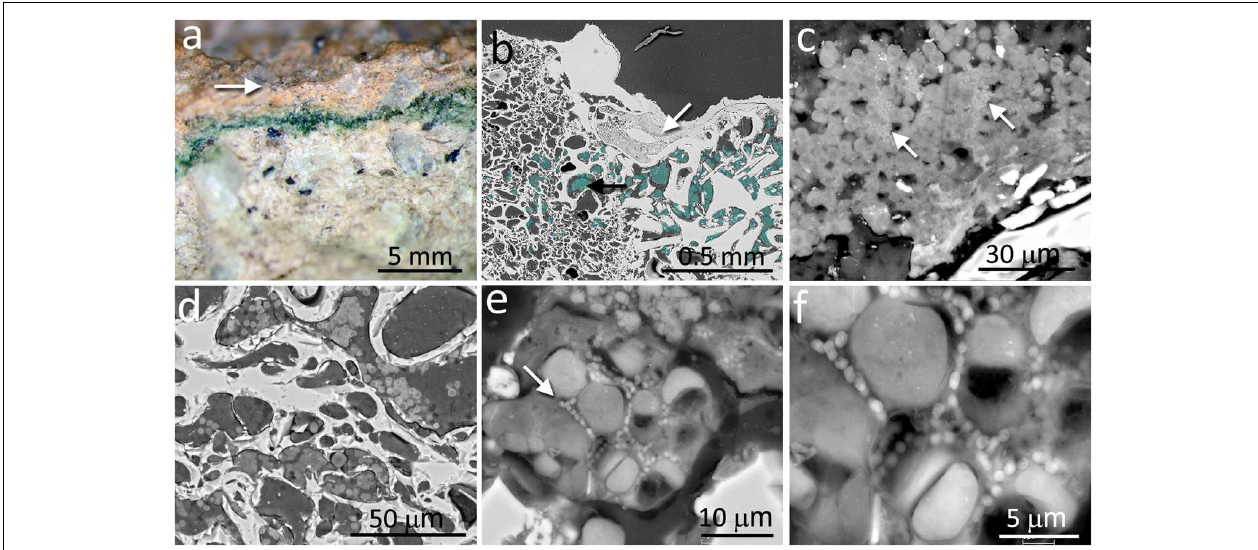
FIGURE 2 | Cryptoendolithic microbial communities within the pores of ignimbrite. (a) Freshly fractured ignimbrite shows a narrow green layer of cryptoendolithic microorganisms beneath the rock surface (arrow). (b) SEM-BSE image showing micromorphological features of rhyolitic ignimbrite composed of glass shards welded together forming bottle-shaped vesicles (left side of image) and irregular-shape pores (right side of image); white arrow points to surface pores filled by varnish rock mineral components; aggregates of cryptoendolithic microbial colonization were marked by cyan-color and black arrow points to aggregates shown in detail in c . (c) SEM-BSE image of cyanobacteria-composed aggregates containing heterotrophic bacteria (white arrows). (d) SEM-BSE image of empty and colonized bottle-shaped pores. (e) SEM-BSE image of a detailed view of cyanobacteria aggregates containing heterotrophic bacteria (white arrow). (f) Magnified central part of (e) showing heterotrophic bacteria in close position to collapsed cyanobacteria and their remains.